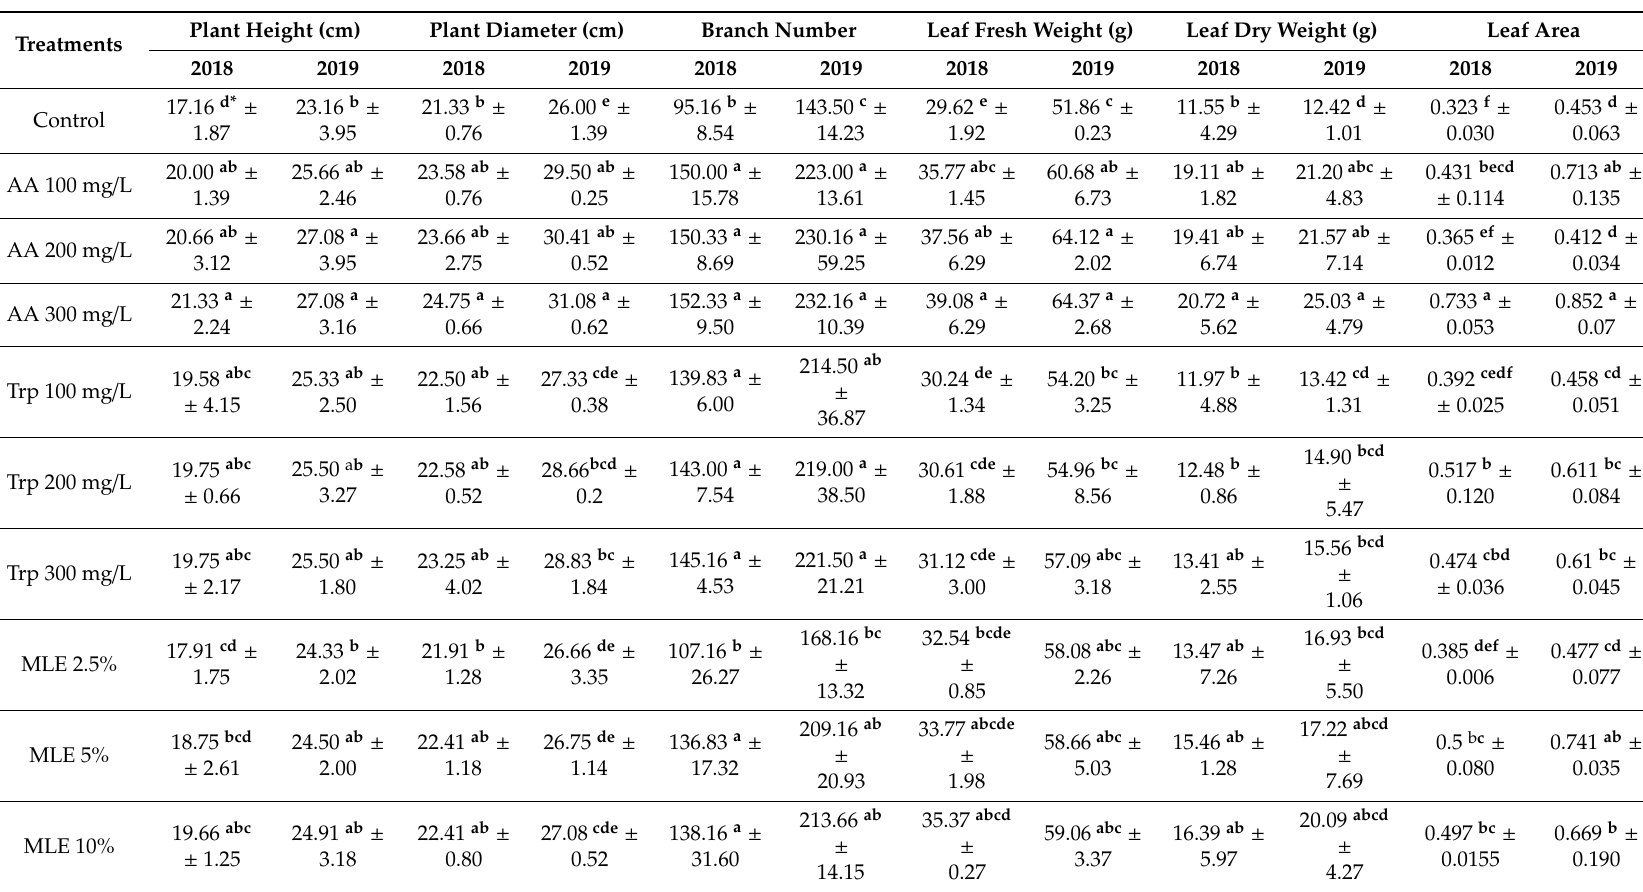
Table 1. Vegetative parameters of O. majorana plants treated with ascorbic acid (AA), tryptophan (Trp) and moringa leaf extract (MLE) in two successive seasons.